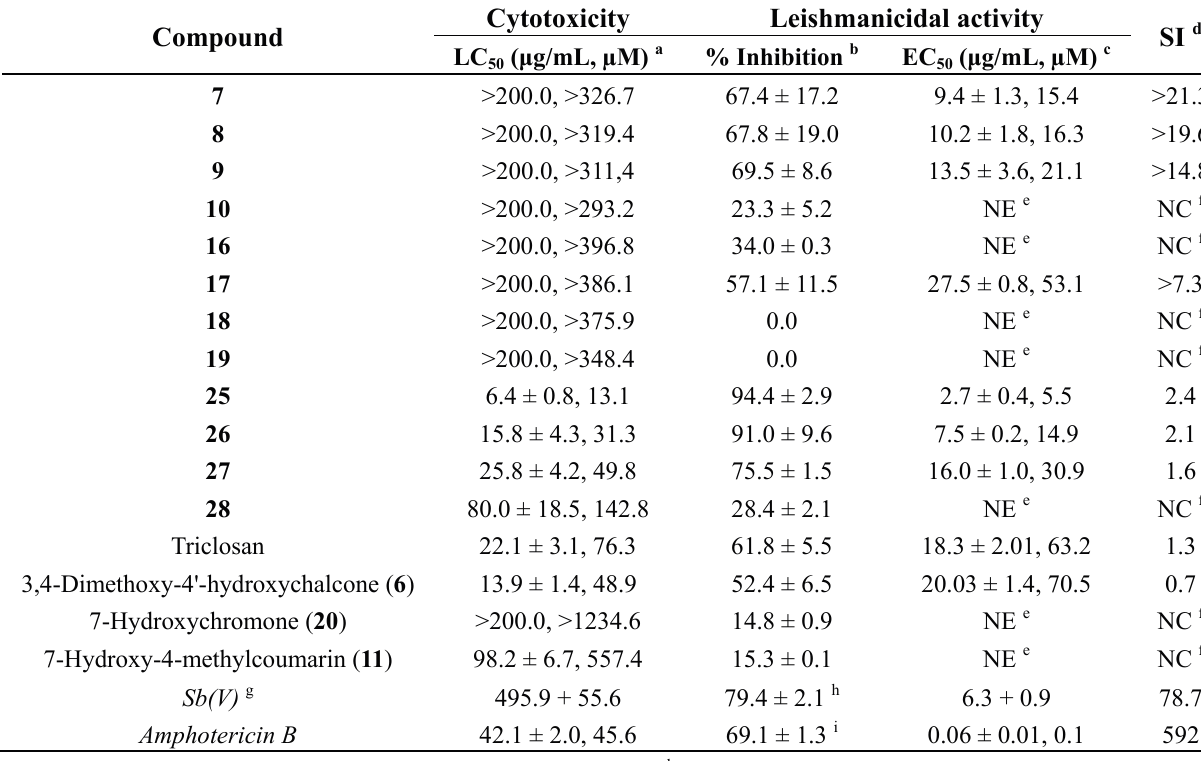
1. In vitro toxicity and anti-Leishmania activity of triclosan-chalcone, triclosan-chromone and triclosan-coumarin hybrids. Compound